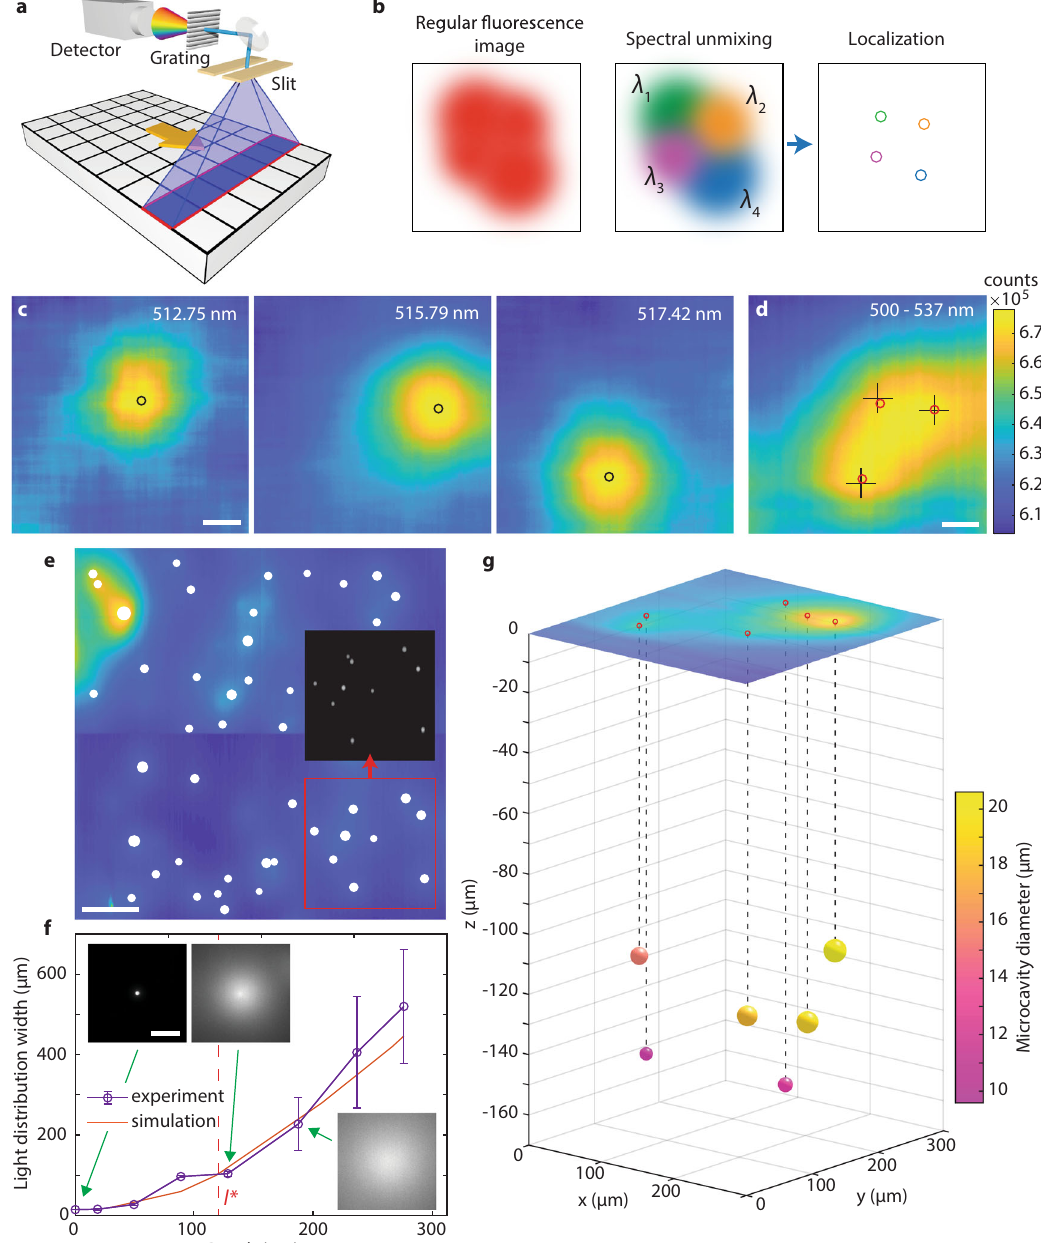
Fig. 2 Localization of the microcavities. a Schematics of the pushbroom hyperspectral imaging. b Principle of the spectral localization. c Intensity images acquired through a phantom (1.7 l * ) at three wavelengths, corresponding to WGM peaks from different microcavities. The circles indicate the reconstructed locations. Scale bar, 50 μ m. d Intensity map summed over all wavelengths equivalent to a regular image. Circles mark the reconstructed locations obtained as the average over all spectral peaks from one microcavity, and crosses mark the actual microcavity locations measured without the phantom. Scale bar, 50 μ m. e Localization and size measurement of a large number (45) of microcavities below a phantom (1.1 l * ). Circle sizes are proportional to the reconstructed sizes of the microcavities. (Inset) Area marked by the red square imaged without the phantom. Scale bar, 500 μ m. f The depth calibration curve obtained by measurement of the light distribution width of the transmitted signal at the phantom surface as a function of the microcavity depth. Each data point is the mean of the distribution width measured on 4 microcavities. For each microcavity the width was measured in four different directions. The error bars represent the standard error of the mean. The simulated curve was obtained by Monte Carlo simulation. (Insets) Images of the corresponding light distributions. Scale bar, 100 μ m. g 3D reconstruction of the locations for the microcavities dispersed inside the phantom. The color of the spheres indicates the microcavity size and the image at the top shows the fl uorescence intensity distribution at the phantom of 40 μ m and therefore three-dimensional localization of the calibration curve was obtained by simulation or by imaging microcavities embedded inside the scattering medium at a depth microcavities at known depths and measuring the width of the of 2.3 l * (Fig. 2g). The depth localization accuracy was estimated light distribution at the surface (Fig. 2f). The calibration curve enables measurement of the microcavity depth with an accuracy by calculating the depths of multiple microcavities beneath a